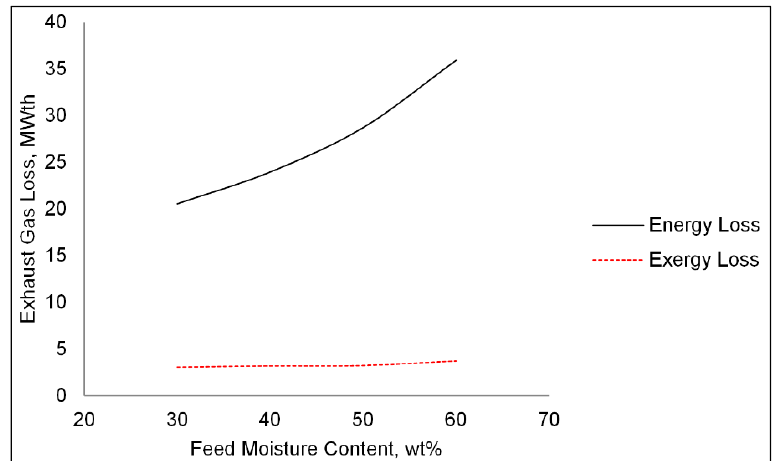
Figure 14. The effect of feed moisture content on energy and exergy losses through waste product in the integrated system, T = 850 °C, S / B = 0.85.